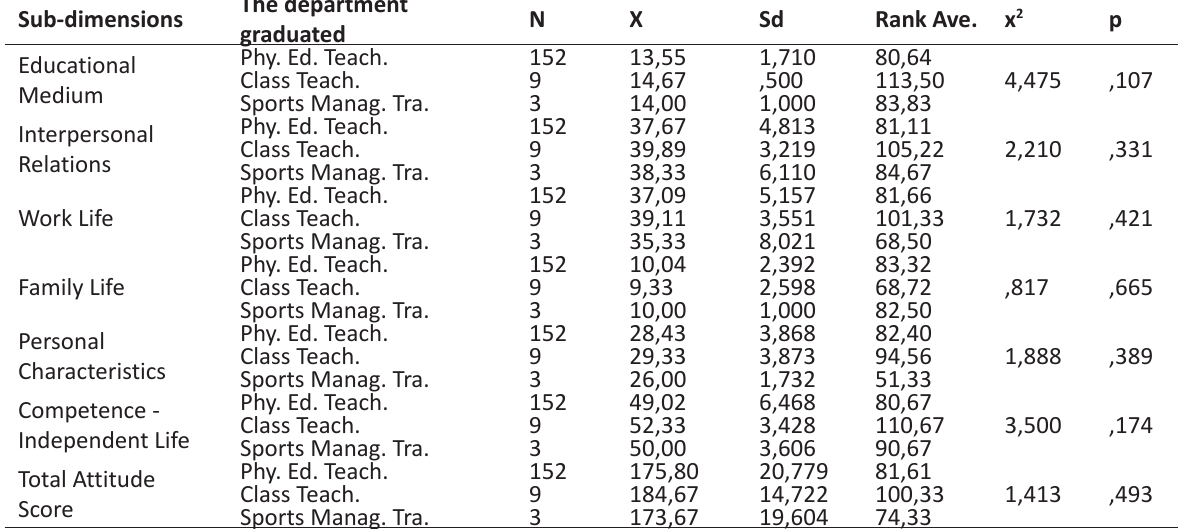
Table 6. Comparison of the Attitude towards the Handicapped Scores of the Participants according to the Graduation Fields